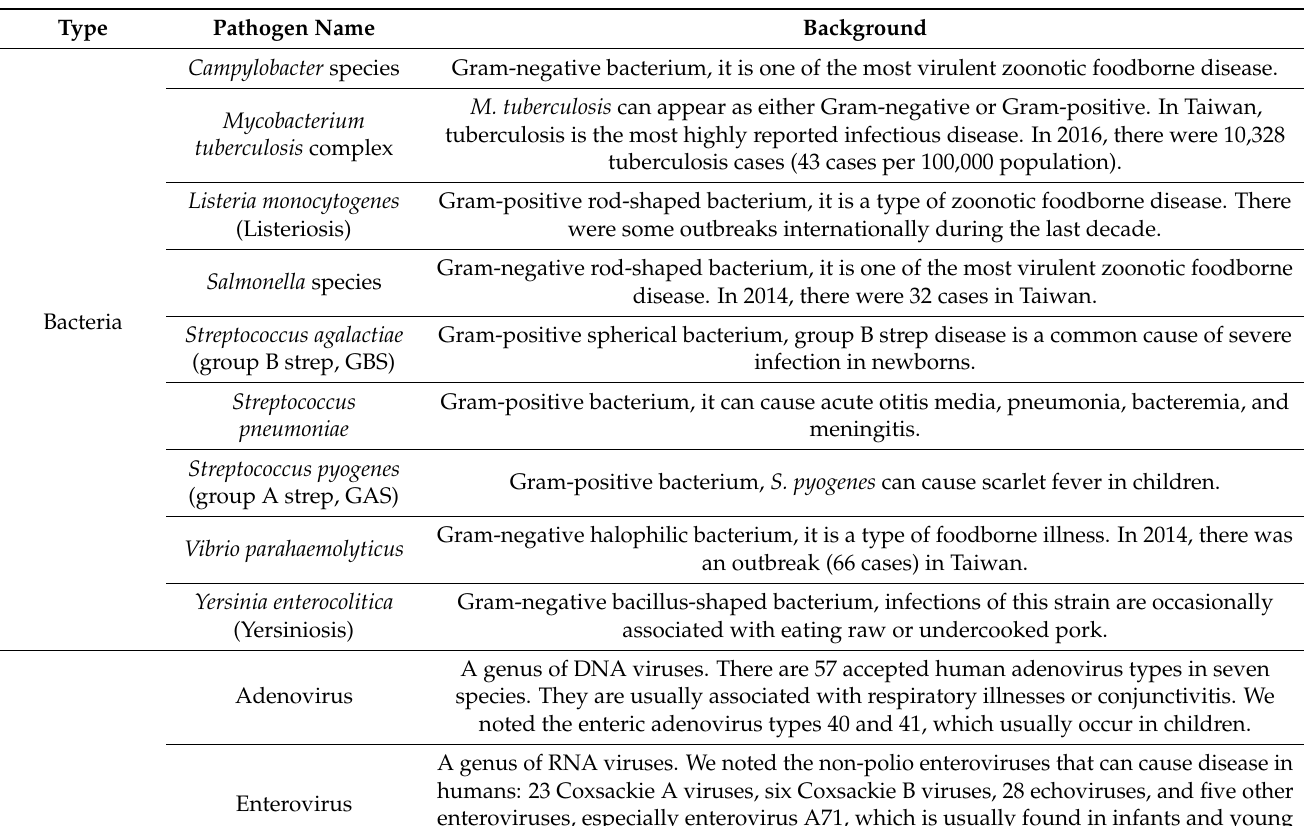
Table 1. Notification conditions